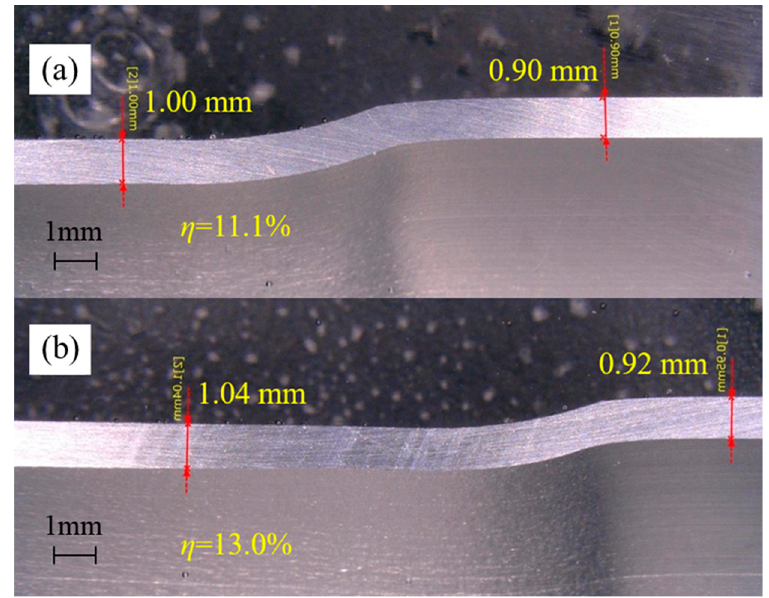
Figure 8. Cross-section of the tube ( a ) κ D = 10.5 %, n = 85 rpm, f = 1.5 mm / rev, feed direction: chuck to free side ( b ) κ D = 10.5 %, n = 85 rpm, f = 1.5 mm / rev, feed direction: free side to chuck.